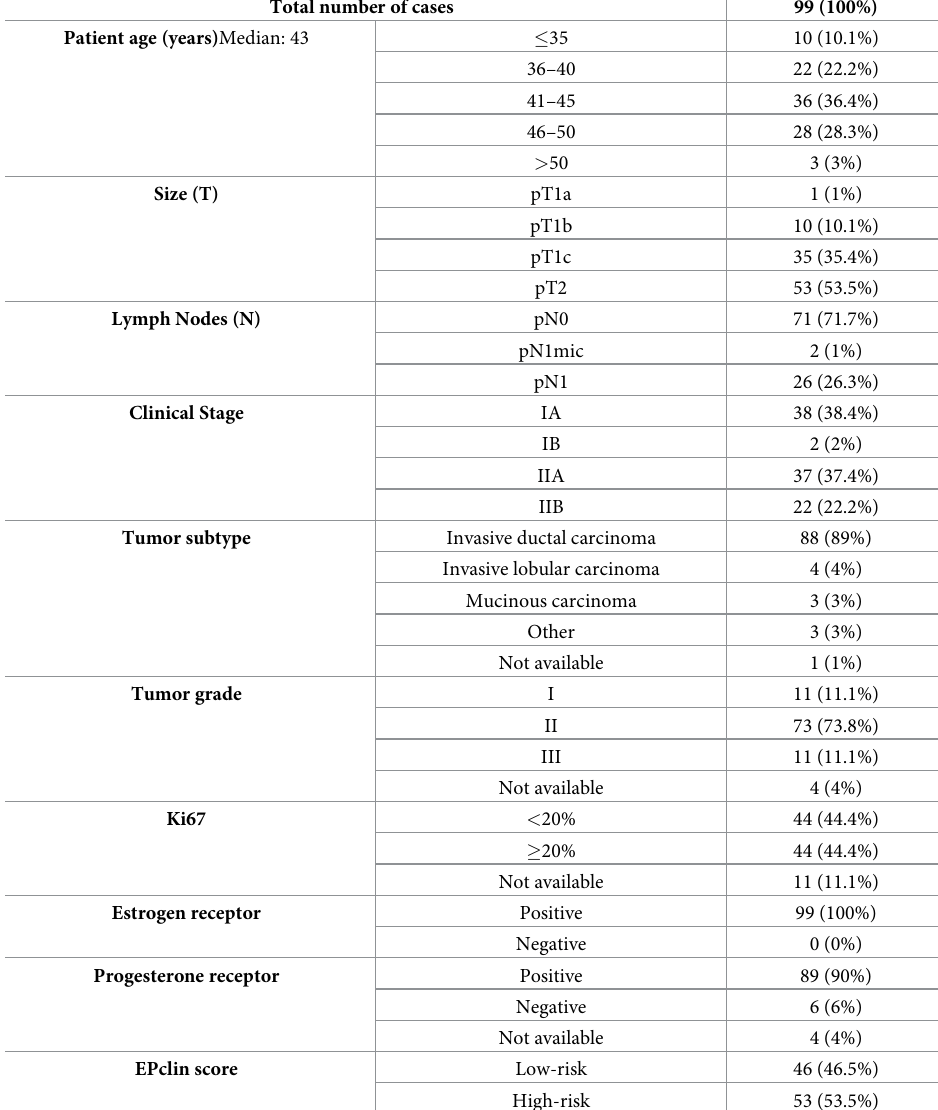
Table 1. Patients’ clinical and pathological